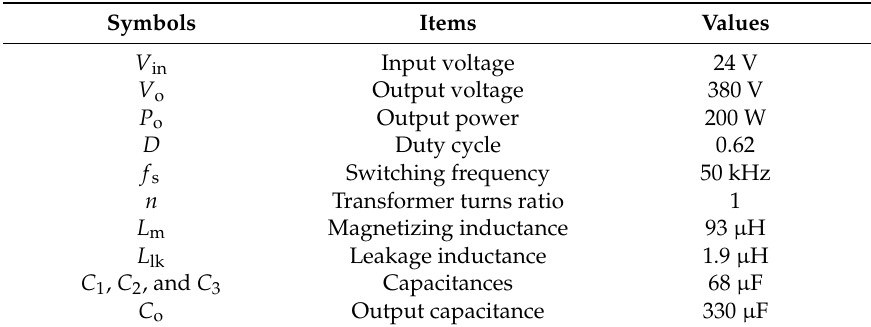
Table 2. Specifications of the proposed converter.